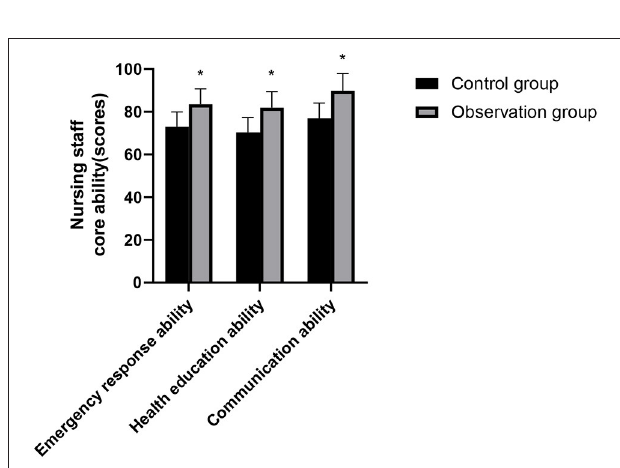
FIGURE 5 | Nursing staff core ability comparison between the two groups. Compared with the control group, * p <